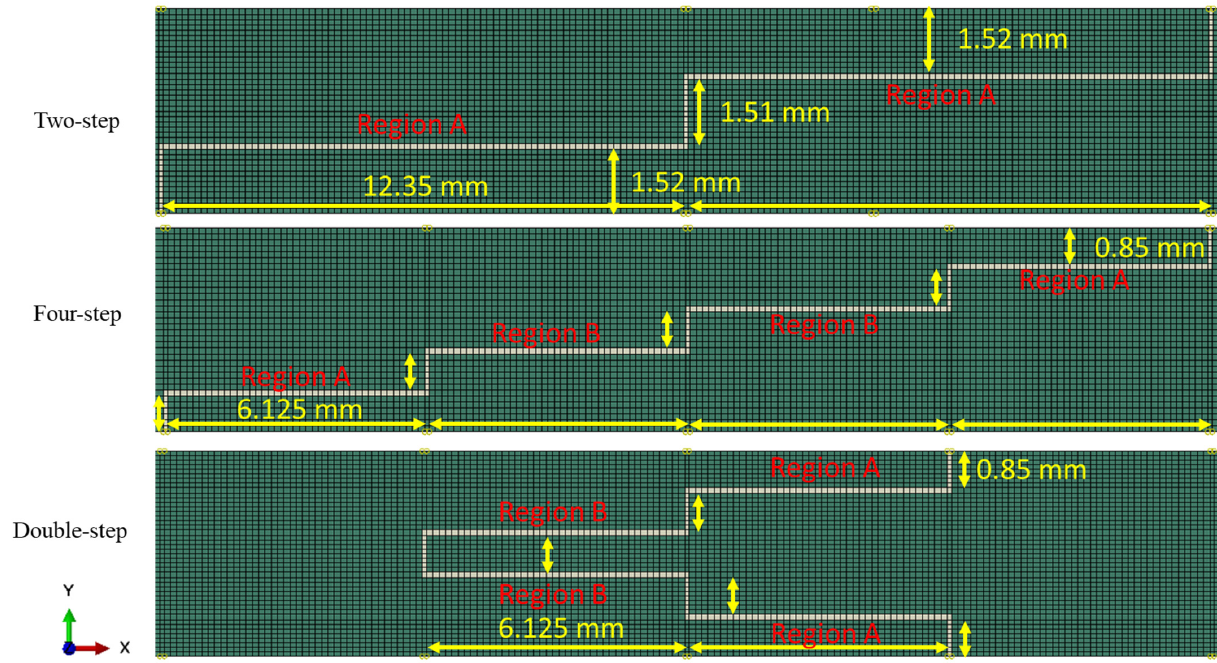
Figure 2. Geometric details of the two ‐ step ‐ , four ‐ step ‐ , and double ‐ step ‐ lap joints.